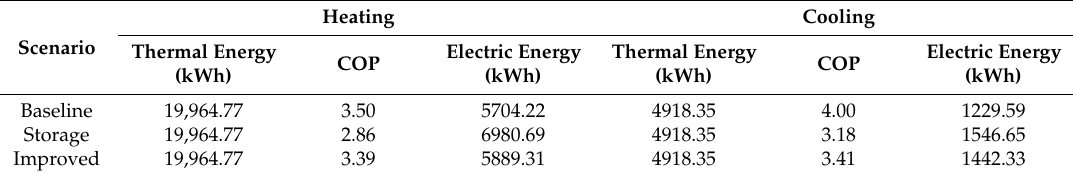
Table 3. Thermal and electric energy consumptions used for the life-cycle assessment